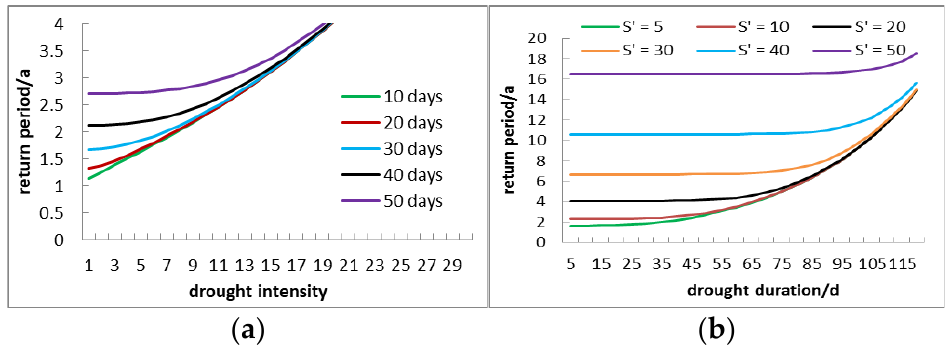
Figure 7. Conditional recurrence period for a drought intensity with a duration exceeding d′ ( a ) and the conditional recurrence period of a drought duration with a severity exceeding s′ ( b ) at the Fuxin station.